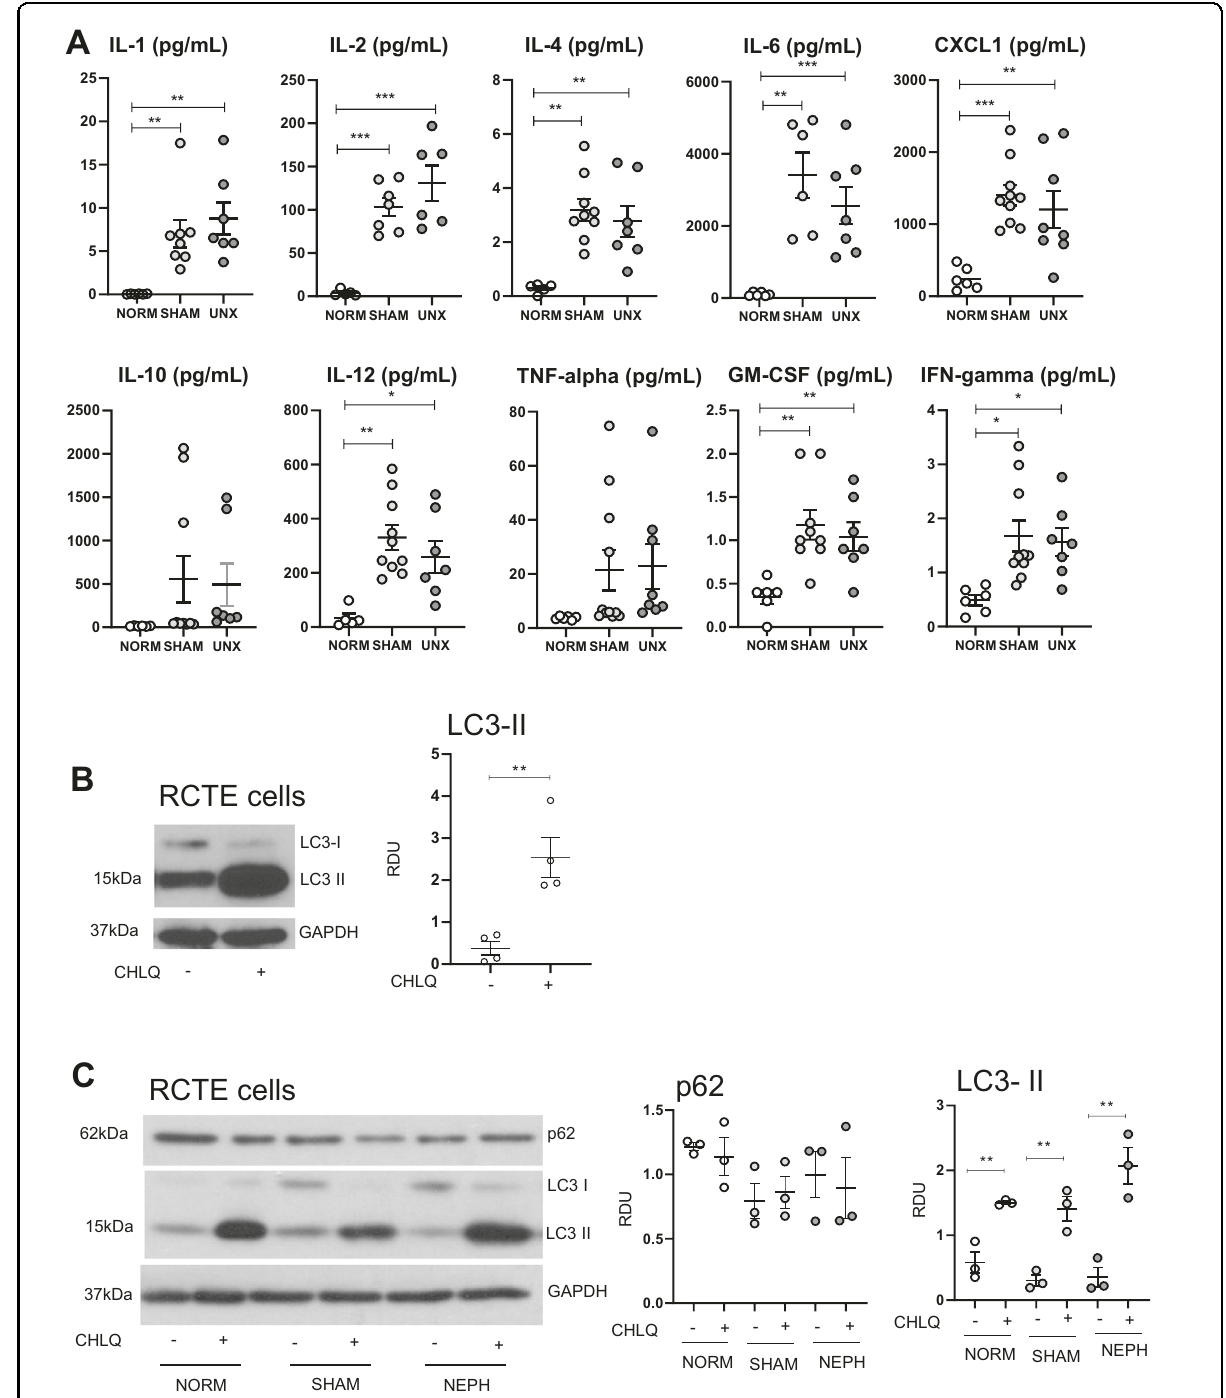
Fig. 6 Pro-in fl ammatory cytokine “ storm ” in the serum after sham surgery and UNX. Serum from normal, sham surgery or UNX mice did not suppress autophagic fl ux in RCTE cells. Mice underwent either no surgery, sham surgery, or UNX and were sacri fi ced after 2 h. A A panel of pro-in fl ammatory cytokines was measured in the serum: IL-1 β , IL-2, IL-4, IL-6, CXCL1 (also known as IL-8 in humans and KC in mice), IL-10, IL-12, GM- CSF, IFN- γ , TNF- α . RCTE cells were treated with B normal medium or C medium containing 10% serum from normal mice, sham surgery or UNX mice. Immunoblot analysis of LC3-II and p62 in RCTE cells with or without chloroquine (CHLQ) with representative densitometry is demonstrated. Immunoblots were corrected for the endogenous control, GAPDH. * P < 0.05, ** P < 0.01, *** P <